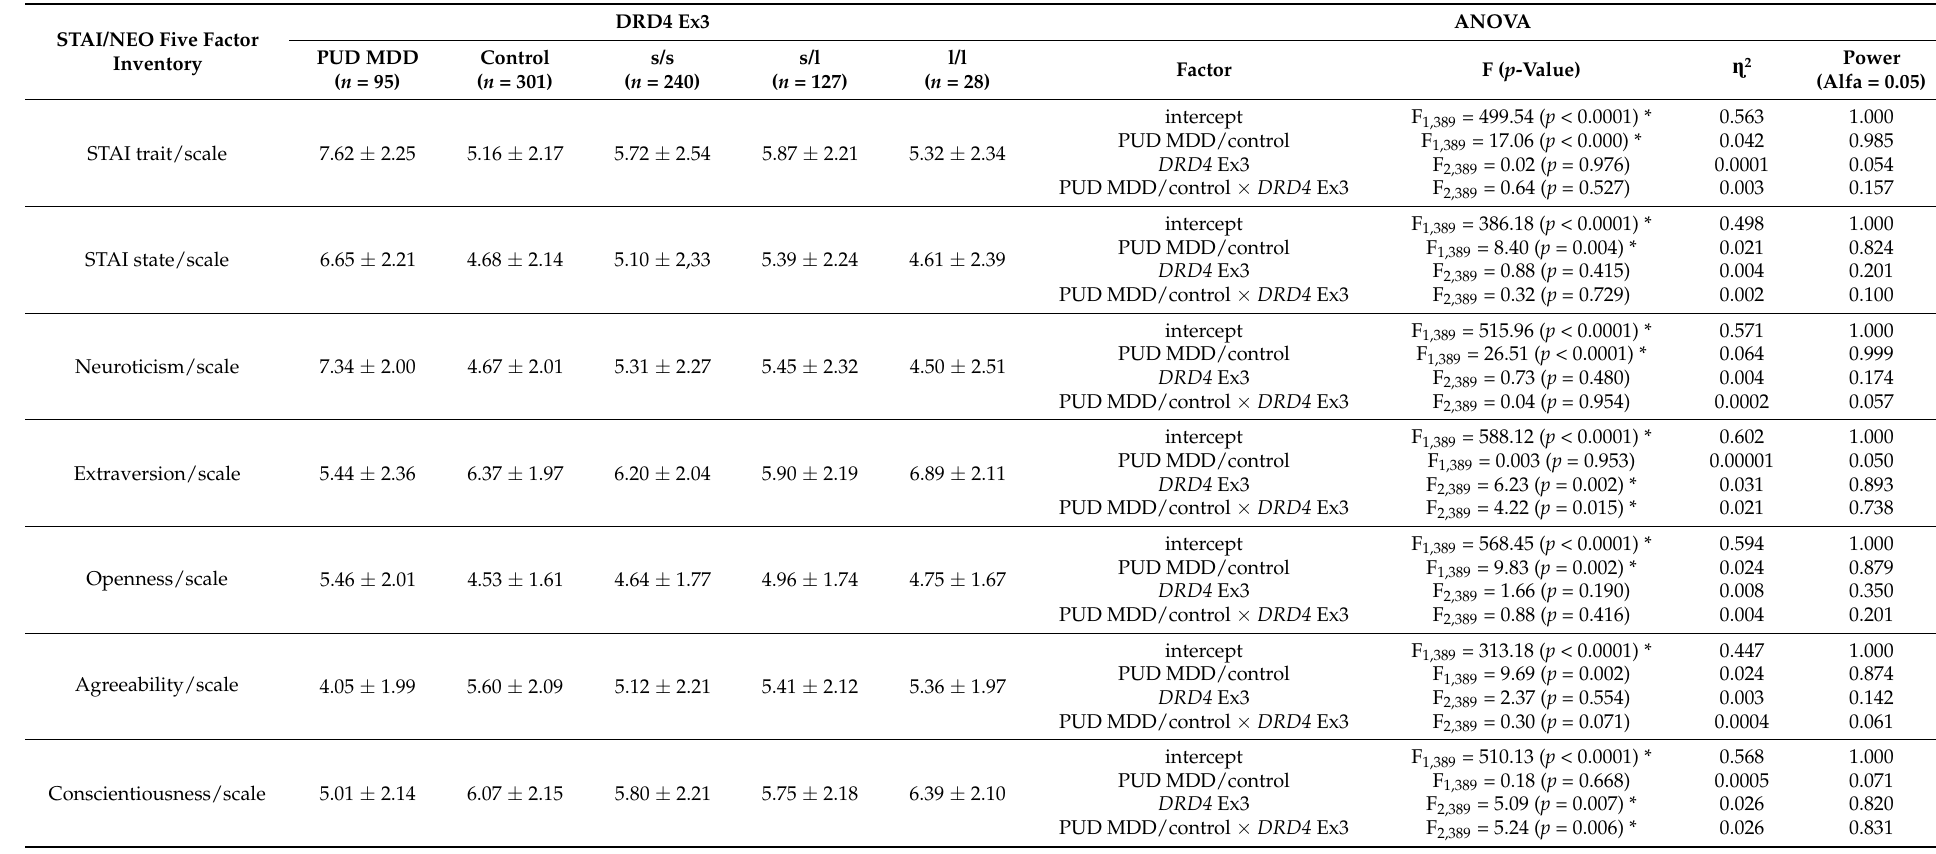
Table 5. Differences in DRD4 exon 3 ( DRD4 Ex3), the NEO Five Factor Inventory, and the STAI scale between healthy controls and PUD MDD subjects. Table 6. Differences in DRD4 exon 3 ( DRD4 Ex3), the NEO Five Factor Inventory, the STAI scale between healthy controls and PUD